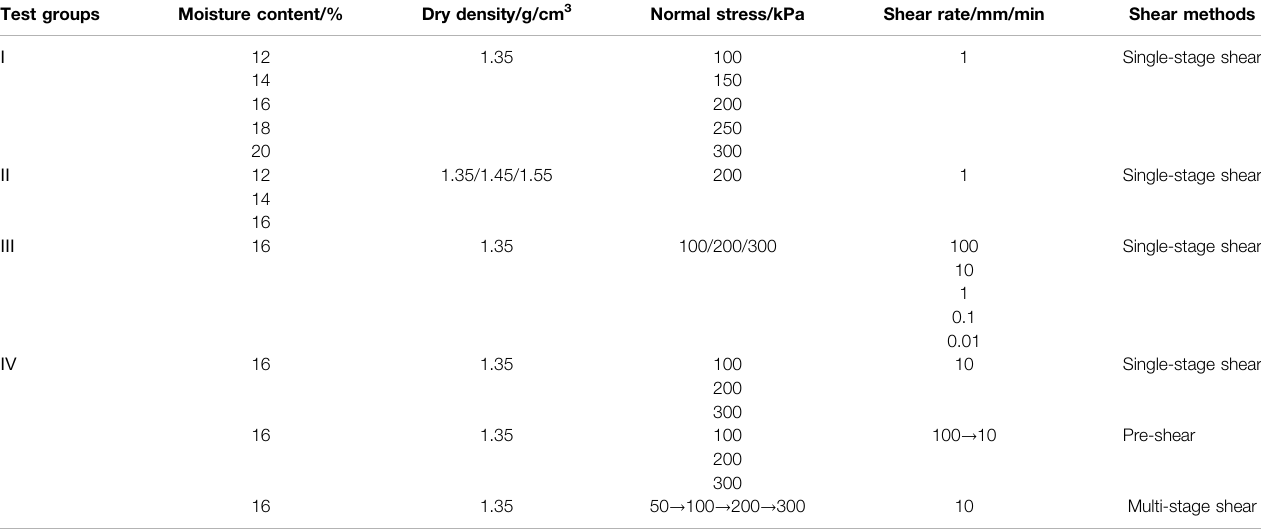
TABLE 2 | Ring shear test